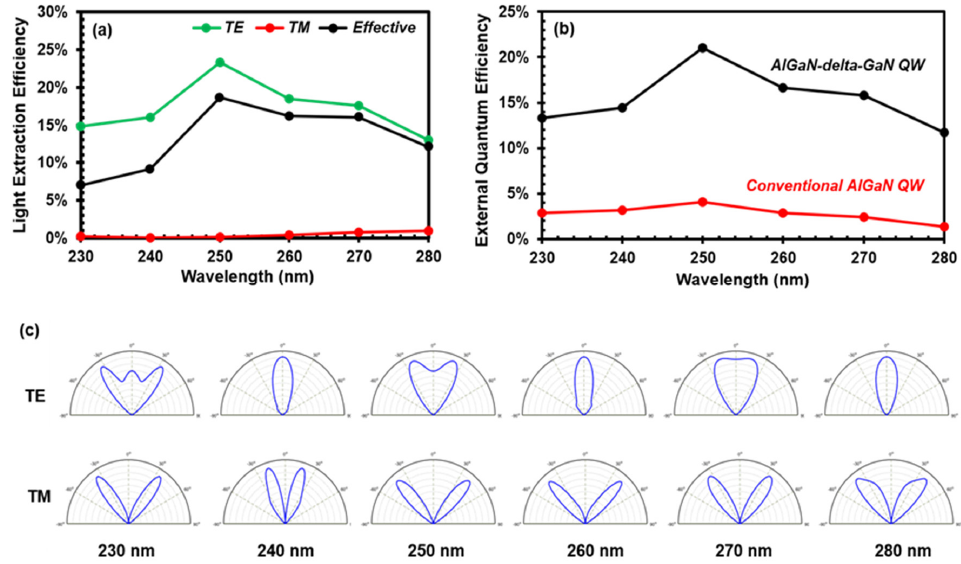
Figure 6. ( a ) TE-polarized η EXT (green), TM-polarized η EXT (red), and e ff ective η EXT (black) from the conventional DUV LEDs at di ff erent wavelengths and ( b ) η EQE from conventional AlGaN QW (red) and the AlGaN-delta-GaN QW (black); ( c ) polarized far field patterns from DUV LEDs at di ff erent emission wavelengths.